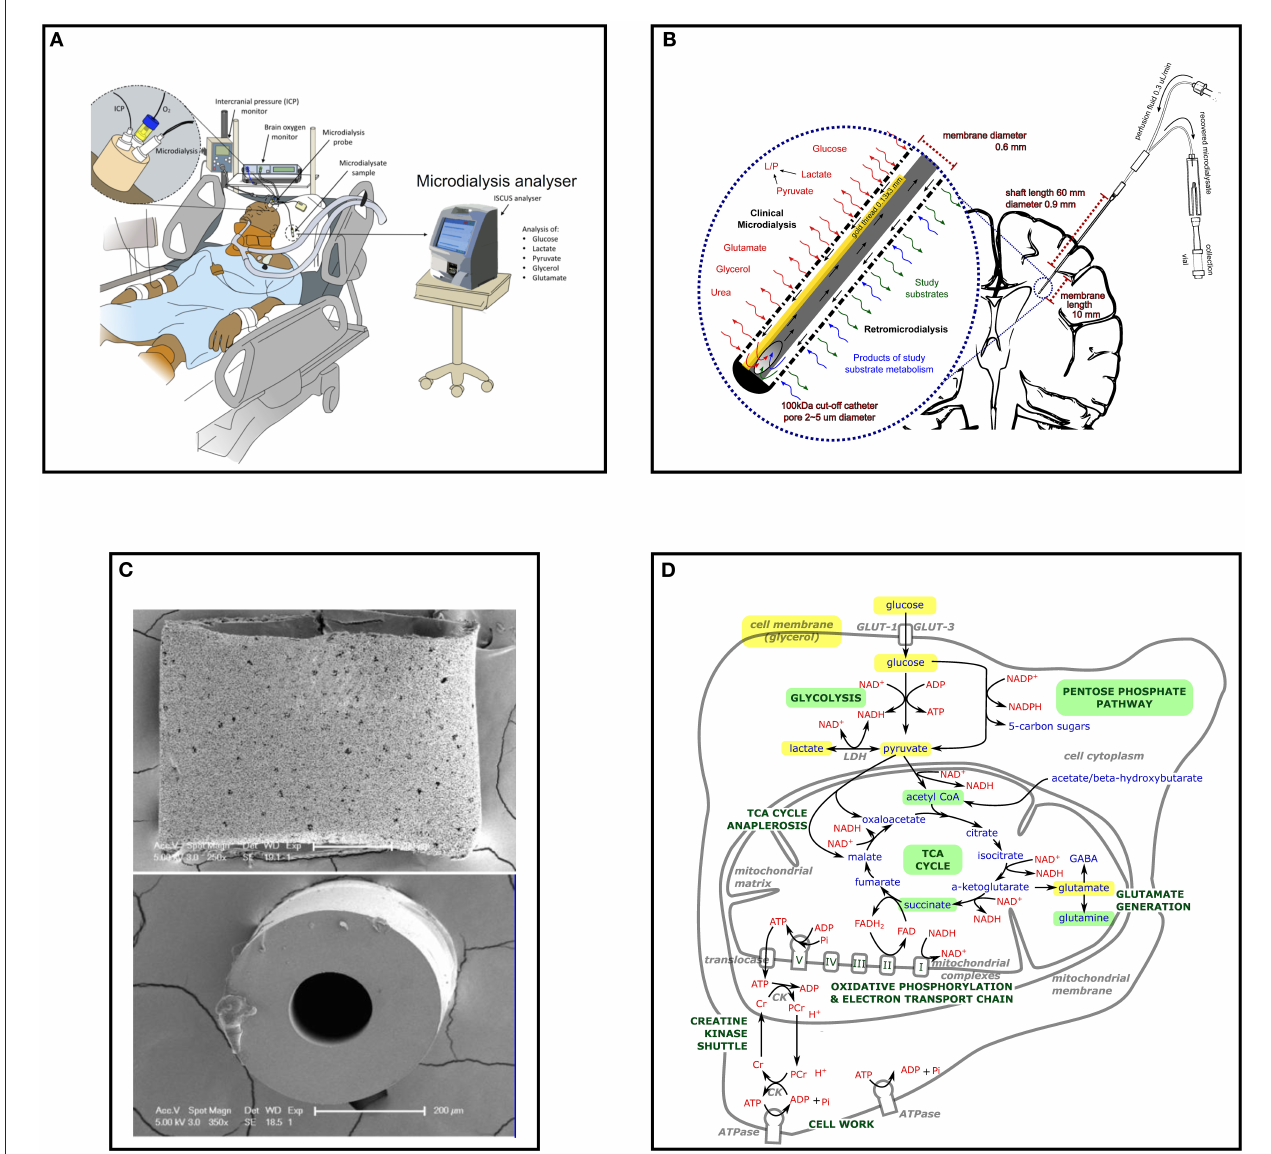
FIGURE1 Cerebral microdialysis from macroscopic to microscopic. (A) Multimodality monitoring in neurocritical care; Illustration of neurocritical care multimodality monitoring including intracranial pressure (ICP), brain tissue oxygen (PbtO 2 ) and microdialysis with an ISCUS/ISCUS flex which are employed alongside standard intensive care monitoring of systemic physiology. Illustration copyright Susan Giorgi-Coll and reproduced here with her permission. (B) Schematic of cerebral microdialysis; 100 kDa cut-off microdialysis catheter inserted into patient’s brain, with magnified view of catheter tip demonstrating semipermeable membrane. A gold filament (0.13 x 3mm) along the end of the catheter allows its identification on CT scans and some MRI sequences. The microdialysis perfusate is pumped slowly (0.3 µ L/min) along the outer lumen, the final 10mm of which is a semipermeable membrane (100 kDa cut-off, outer pore diameter ≈ 2–5 µ m). Small molecules freely exchange with the brain interstitium, approaching equilibrium by the time they reach the recovery hole in the end of the central, non-porous channel, where the fluid passes back for collection in microdialysis vials. Glucose, lactate, pyruvate, glycerol, glutamate and urea may be used for clinical monitoring, illustrated to the left of the expanded window. Catheters can also be used to “dose” the surrounding brain with research substrates (including those with stable isotope 13 C labeling) and recover the resultant products, illustrated to the right of the expanded window. (C) Scanning electron micrograph of M Dialysis 71 microdialysis catheter sectioned transversely; Upper panel the catheter semipermeable membrane (polyarylethersulfone) external surface demonstrating pores several micrometers across. (B) The central polyurethane non-porous inner channel removed from inside a catheter. Originally published in Helmy et al. (2). Copyright Mary Ann Liebert, Inc. and reproduced with permission (2). (D) Schematic of stylized cell with (enlarged) central mitochondrion illustrating principal metabolites and pathways of energy metabolism examined by cerebral microdialysis. Glucose, pyruvate, and lactate are important species in glycolysis and the TCA cycle for energy metabolism and the regeneration of ATP in conjunction with oxidative phosphorylation and the electron transport chain. Glutamate is the principle excitatory neurotransmitter in the brain and glycerol is a key component of cell membranes. All can be interrogated with clinical microdialysis (highlighted yellow). Glycolysis, the pentose phosphate pathway, the TCA cycle and succinate and glutamine metabolism have been investigated